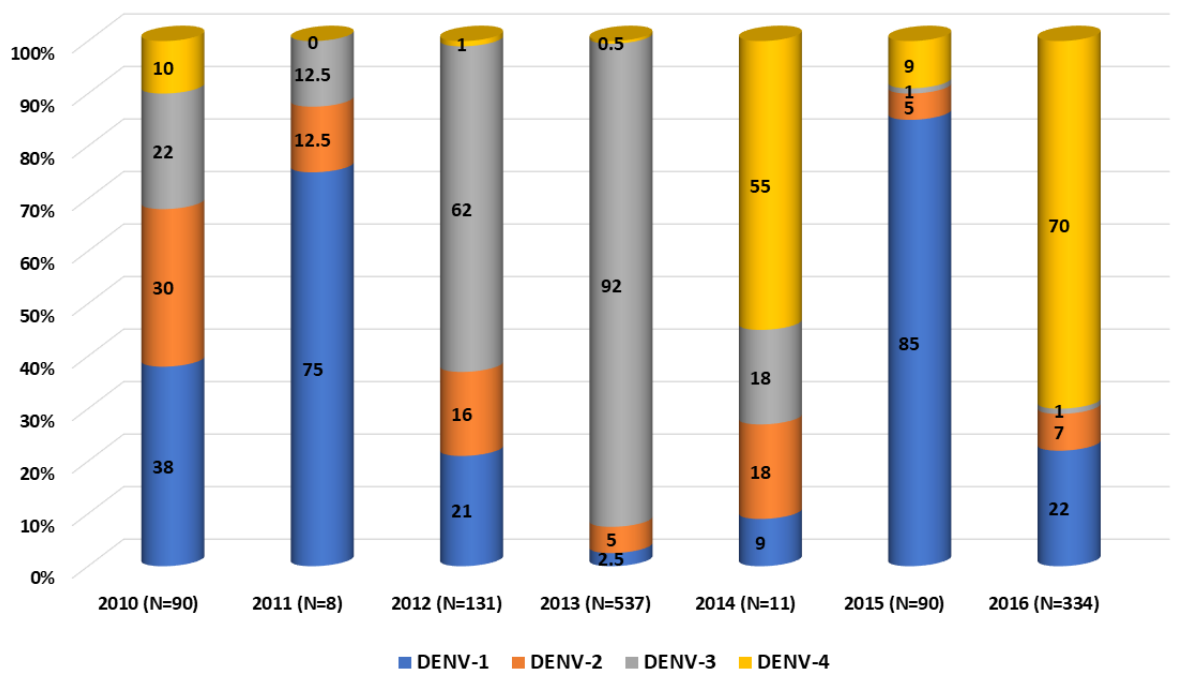
Figure 2. Dengue virus serotypes distribution per year between 2010 and 2016. Compilation of data from 2010 to 2011 [21] and from 2012 to 2016 [20].